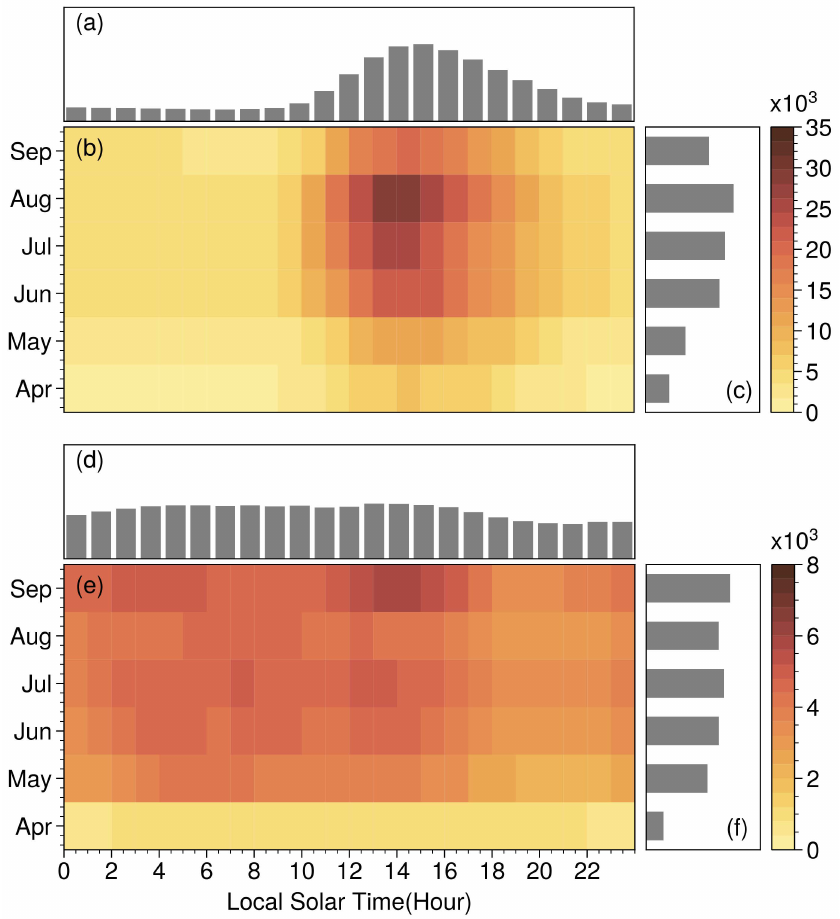
Figure 5. The heatmap of monthly and hourly variability of convective activities, ( a , d ) the histogram of hourly variability, ( b , e ) the month-hour heatmap, and ( c , f ) the histogram of monthly variability of the convective systems over land and ocean,